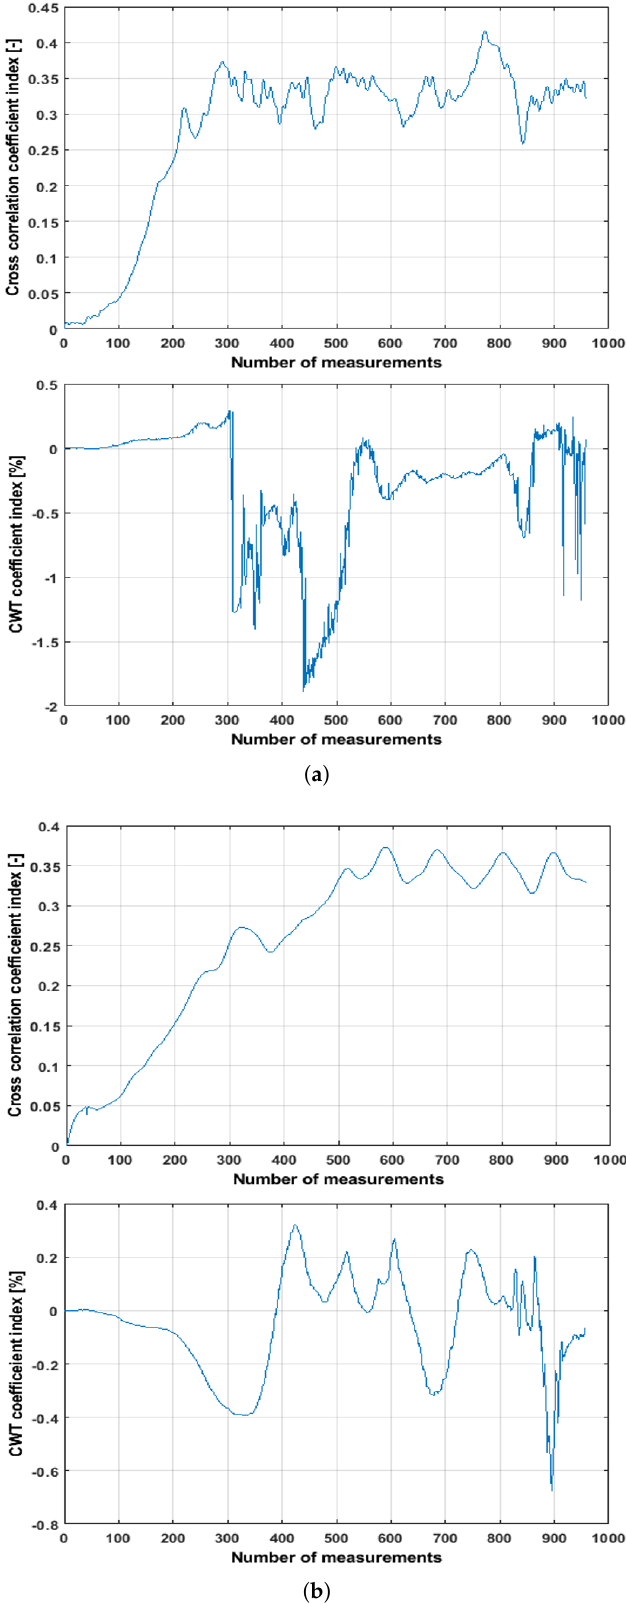
Figure 7. Features computed from the top and bottom pairs of measurements. ( a ) Dcc and CWT coefficients for the bottom pair of signals (S02R03); ( b ) Dcc and CWT coefficients for the top pair of signals